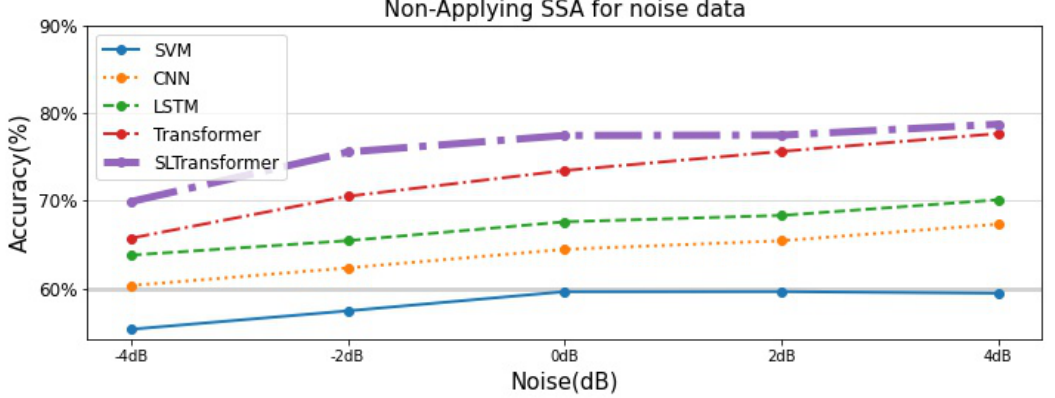
Figure 16. The accuracy graph of non-applying SSA algorithm for noise